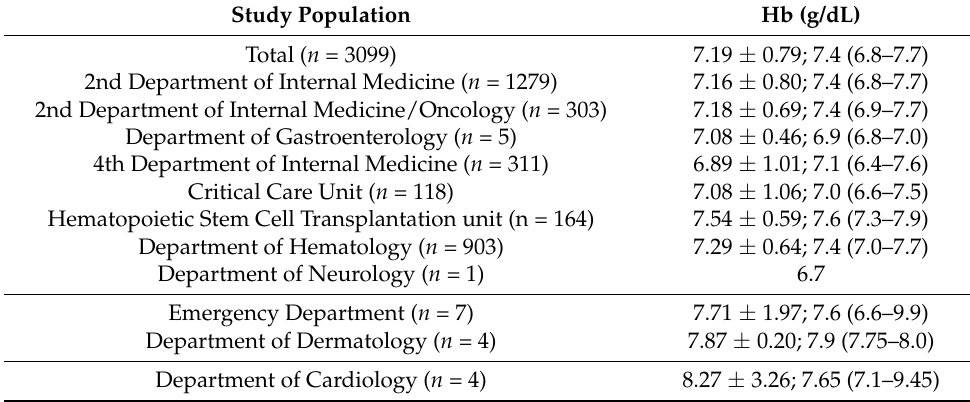
Table 1. Hemoglobin levels of transfused patients without comorbidities.